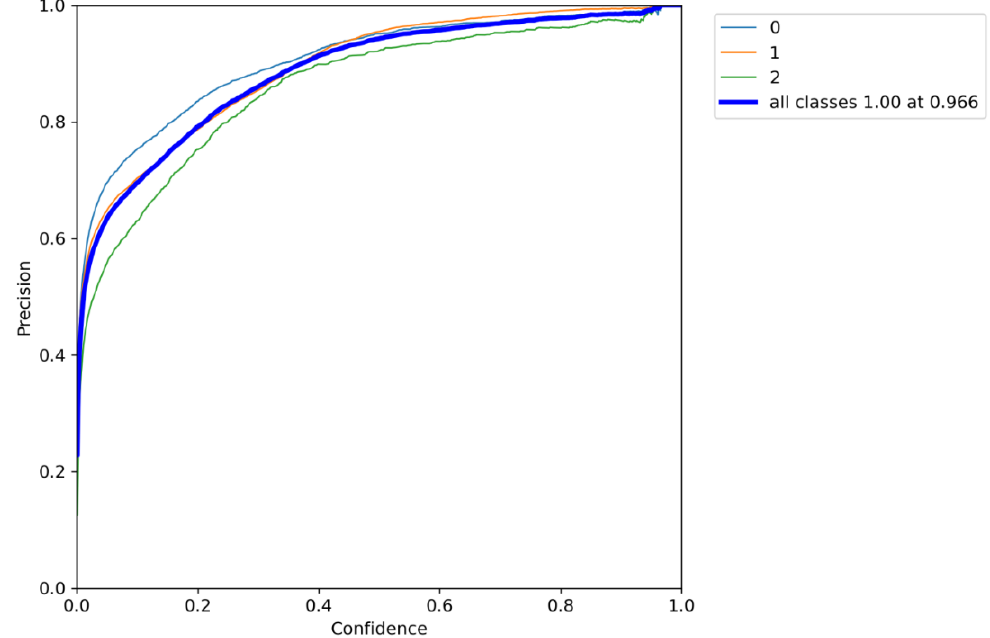
Figure 11. Assessment of precision all classes for YOLO v5 model.